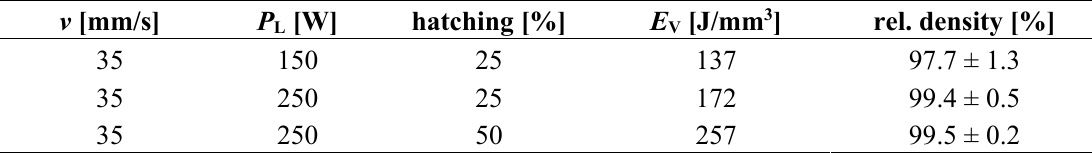
Table 1. Selective Laser Melting (SLM) parameters used for building bulk samples and their related densities measured by Archimedes